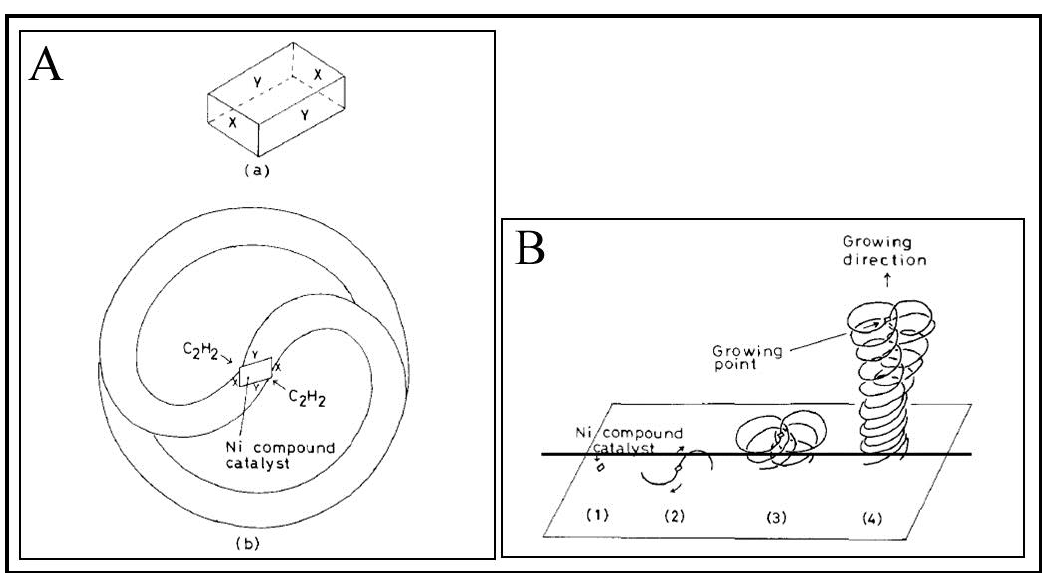
fiber axis. Further, the elastic module of the straight fibers mainly controls the coil diameter, coil length, and coil pitch. Finally, angular momentum conservation is the governing factor for the two coils, which derive from the same catalyst grains, and have opposite helix.